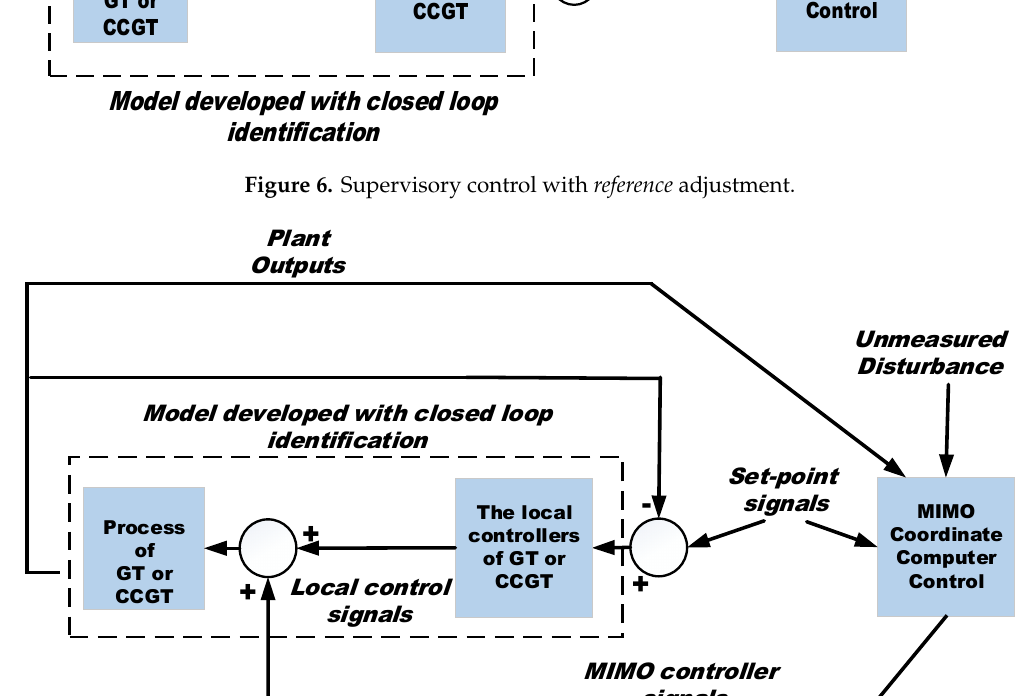
Figure 7. Supervisory control with action adjustment.